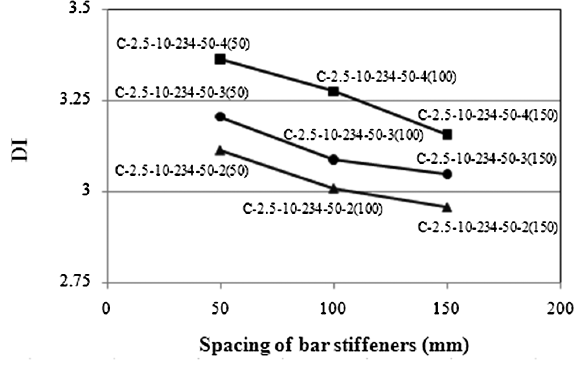
Fig. 13. Effects of number and spacing of bar stiffeners on